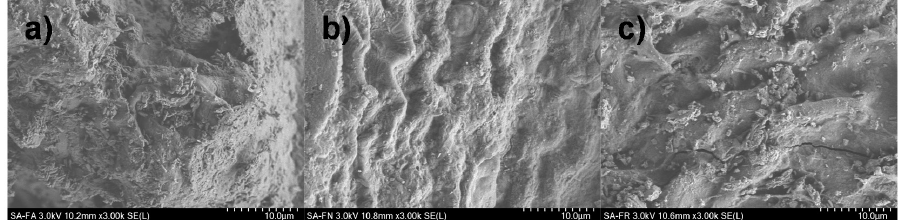
Figure 13. SEM analysis of CT- Sargassum spp. after the removal of: ( a ) methylene blue, ( b ) methyl orange and ( c ) methyl red.